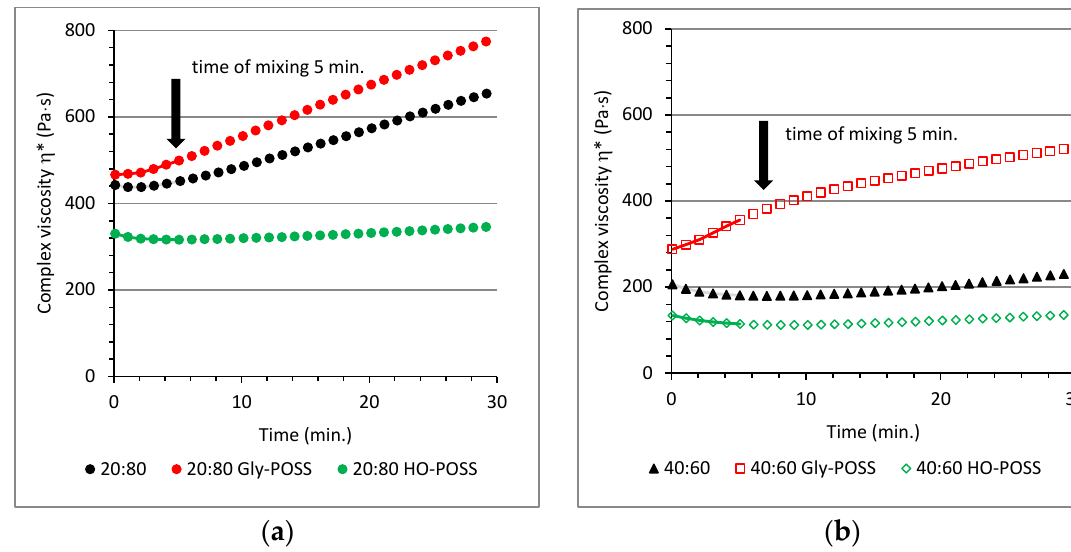
Figure 3. Complex viscosity η * as a function of time at processing temperature 160 °C at constant strain and angular frequency, equivalent of 1 s −1 oscillation strain rate for POSS modified 20:80 PLA/ENR ( a ) and 40:60 PLA/ENR blend ( b ).